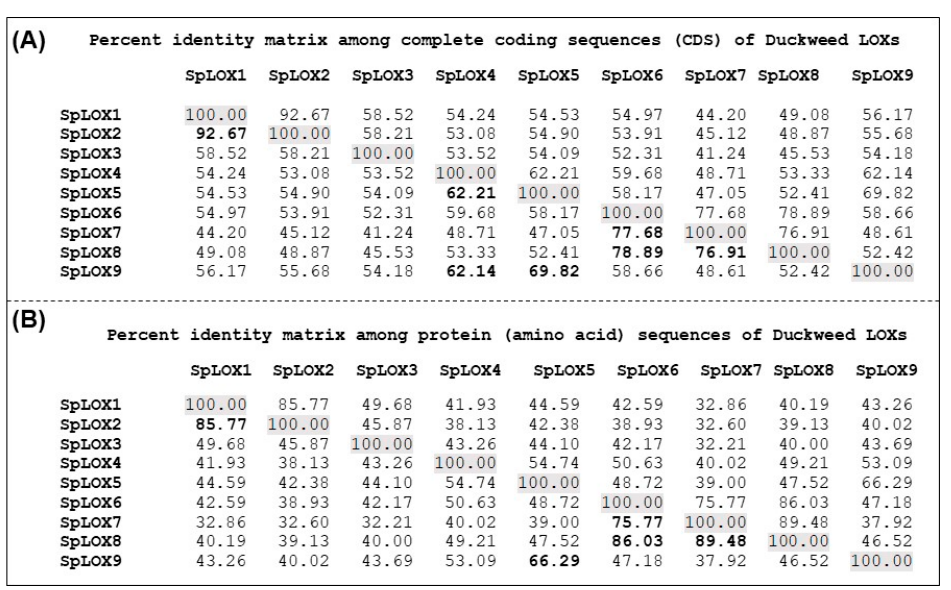
Figure 3. Spirodela LOX family genes’ relatedness and intron-exon arrangements. The evolutionary history was inferred using the maximum likelihood method based on the JTT matrix-based model. The percentage of trees in which the associated taxa clustered together is shown next to the branches. The tree is drawn to scale, with branch lengths measured in the number of substitutions per site. The analysis involved nine amino acid sequences. All positions with less than 95% site coverage were eliminated. Evolutionary analyses were conducted in MEGA7 [51]. The Spirodela LOX subfamilies 9-LOX and 13-LOX are designated, with 13-LOX further separated into type I (13-LOX- I) and type II (13-LOX- II). Schematic genomic organization for each LOX gene was generated using the Gene Structure Display Server (GSDS 2.0; http://gsds.cbi.pku.edu.cn/). Exons (CDS) and introns are represented by blue boxes and black dashed lines, respectively. The sizes of exons and introns are proportional to their sequence lengths. Int. J. Mol. Sci. 2020 , 21 , x FOR PEER REVIEW